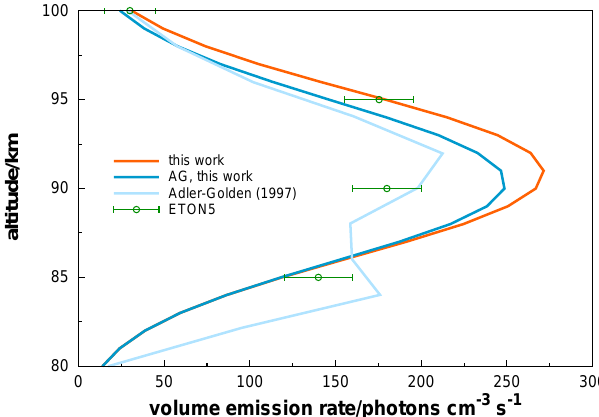
Fig. 6. Vertical profiles of the volume emission rate for the 8-3 band obtained using the empirical O + OH ( v ′ ) rate constant from Adler- Golden (1997) and those from the present work based on the QCT calculations from Varandas (2004a). Also shown are the originally reported data of Adler-Golden (1997) and the ETON 5 experimental volume emission rate measurements (McDade et al., 1987).